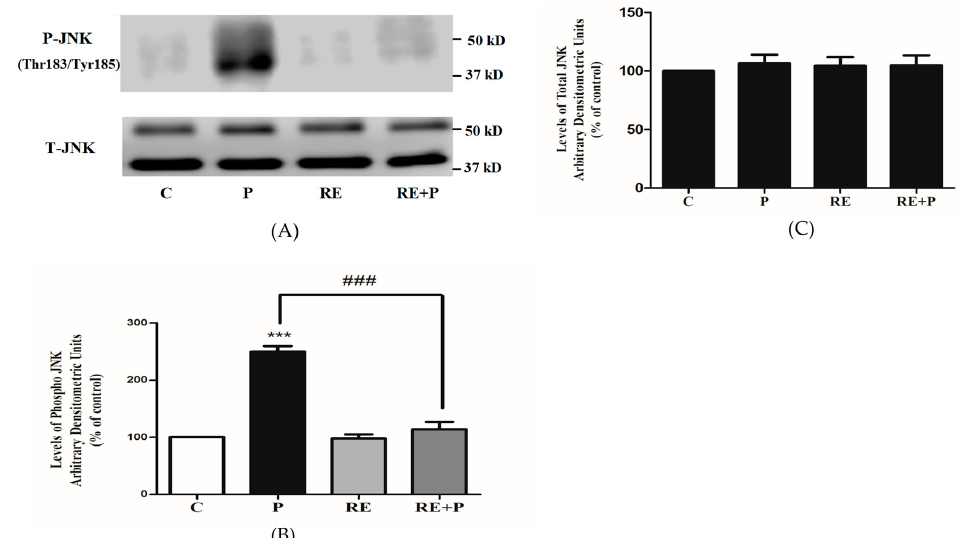
Figure 5. Effects of palmitate and RE on JNK expression and phosphorylation. Fully differentiated myotubes were treated without (control, C) or with 0.2 mM palmitate (P) for 16 h in the absence or the presence of 5 µ g/mL RE. After treatment, the cells were lysed, and SDS-PAGE was performed, followed by immunoblotting with specific antibodies that recognize phosphorylated Thr183/Tyr185 or total JNK. Representative immunoblots are shown ( A ). The densitometry of the bands was measured and expressed in arbitrary units ( B , C ). The data are the mean ± SE of three separate experiments (*** p < 0.001 vs. control, ### p < 0.001 vs. palmitate alone).